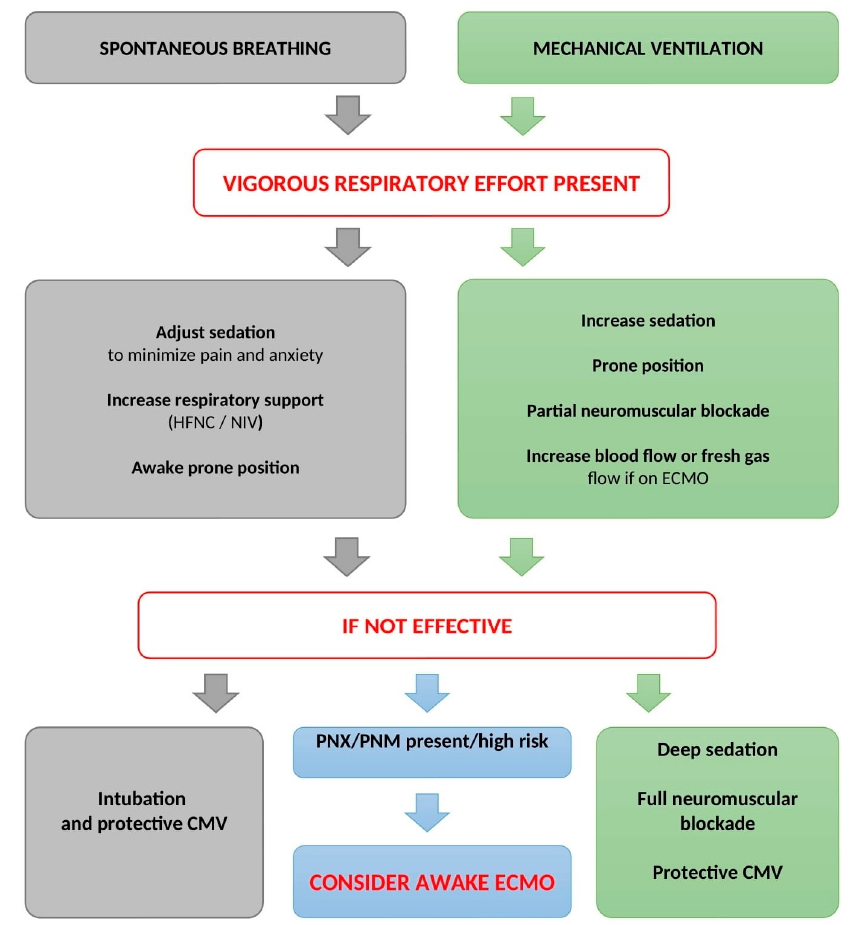
Figure 3. Proposal of an algorithm for P-SILI prevention and treatment. CMV—controlled mechanical ventilation; HFNC—high-flow nasal cannula; NIV—noninvasive ventilation; PNX—pneumothorax; PNM—pneumomediastinum; ECMO—extracorporeal membranous oxygenation.